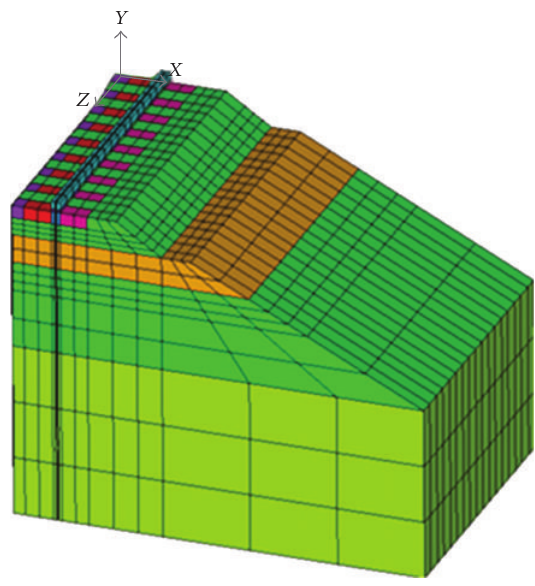
Figure 3: Track model